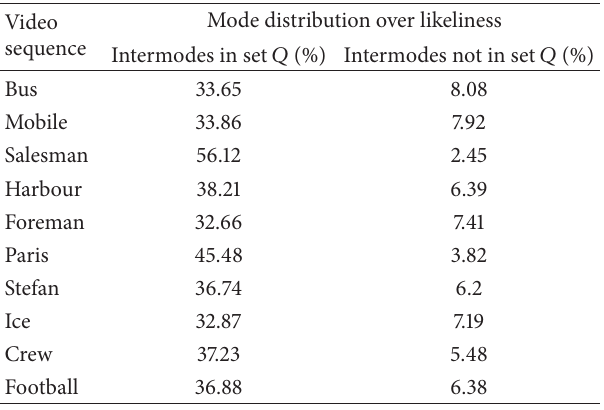
Table 1: Macroblock average likeliness under various QP. Table 2: Intermode distribution based on average likeliness.